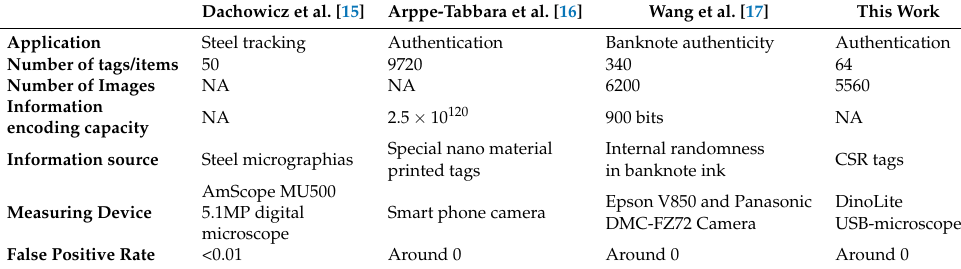
Table 1. Comparison between different authentication technologies.